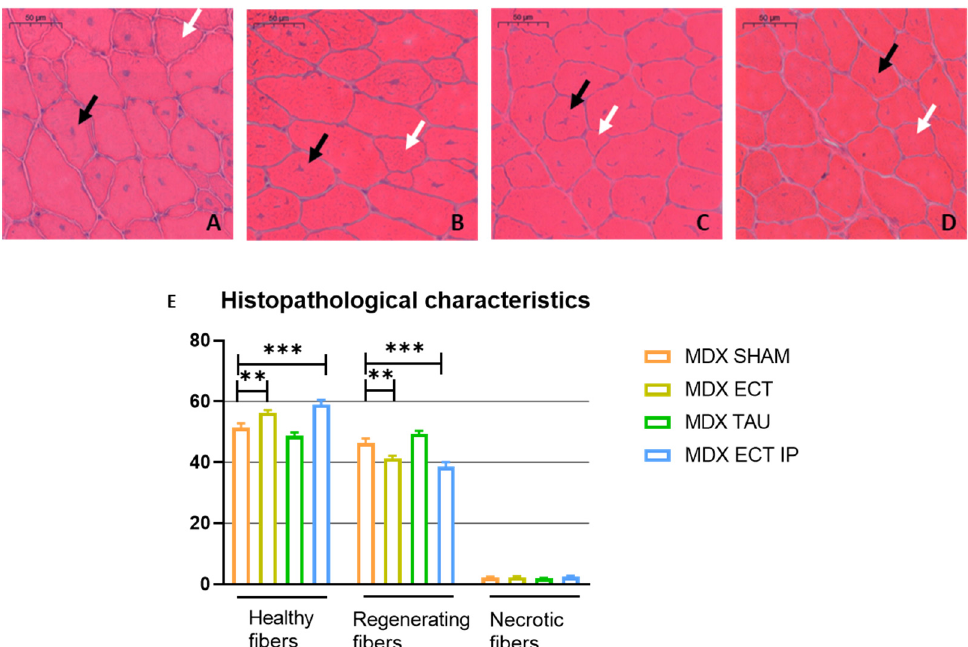
Figure 4. Histopathological features of sham-treated and osmolyte-treated mdx mice. H&E-stained section of ( A ) sham-treated mdx mice; ( B ) ectoine-treated mdx mice through oral administration; ( C ) taurine-treated mdx mice through oral administration; ( D ) I.p. ectoine injected mdx mice. Healthy (white arrows), regenerating (black arrows) and necrotic fibers (not illustrated) were quantified in three sections per animal (>150 µ m apart), yielding analysis of a total of 117 sections. ( E ) Histopathological characteristics of H&E-stained sections of sham-treated ( n = 8), oral ectoine- treated ( n = 11) and i.p. ectoine- treated mice ( n = 9). Data are presented as mean ± SEM, and statistical analysis revealed significant differences between sham-treated mdx mice and other groups (Table S1). Significant differences are annotated by ** ( p < 0.01) and *** ( p < 0.001). Scale bar = 50 µ